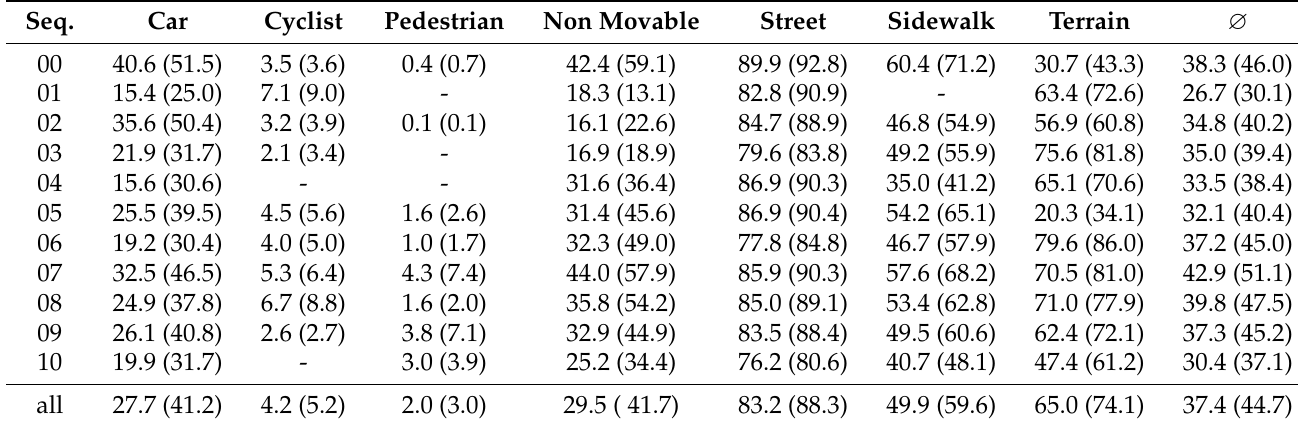
Table 2. Class IoUs IoU ω (IoU (cid:48) ω ) for the monocular vision pipeline in %. The dash indicates that there are no corresponding objects in the sequence. The column on the right contains the mean IoUs mIoU (mIoU (cid:48) ). Seq.